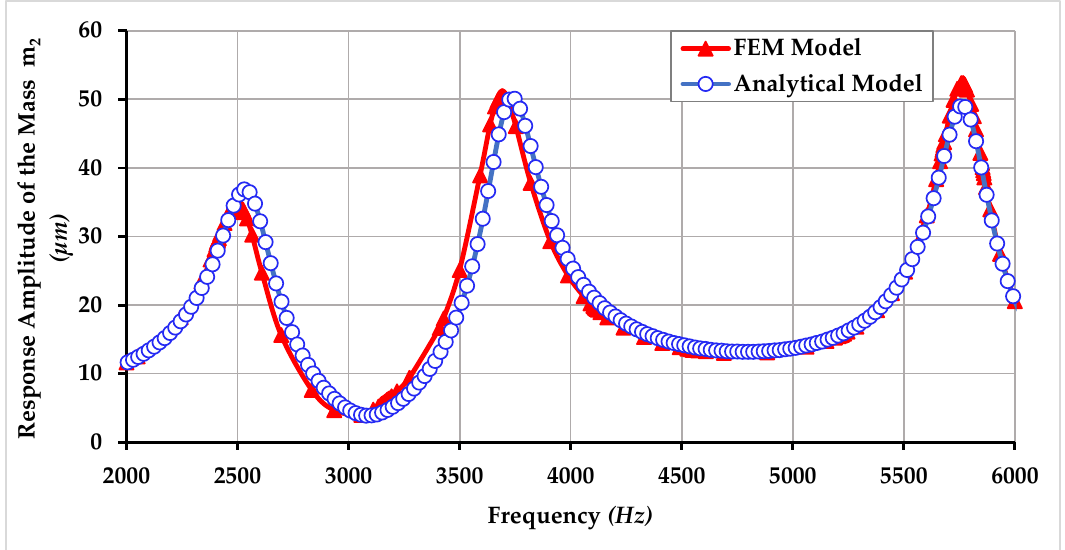
Figure 23. Comparison of response amplitude of the mass 𝑚 2 of the proposed MEMS gyroscope obtained using FEM and an analytical model.